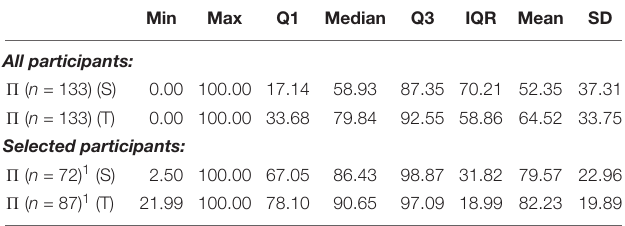
TABLE 5 | Percentage occurrence of HRA in 150-beat sliding windows for all 133 participants, 72 with short-term HRA occurrence registered in 5-min recording in supine and 87 with short-term HRA occurrence registered in 5-min recording in tilt. Min Max Q1 Median Q3